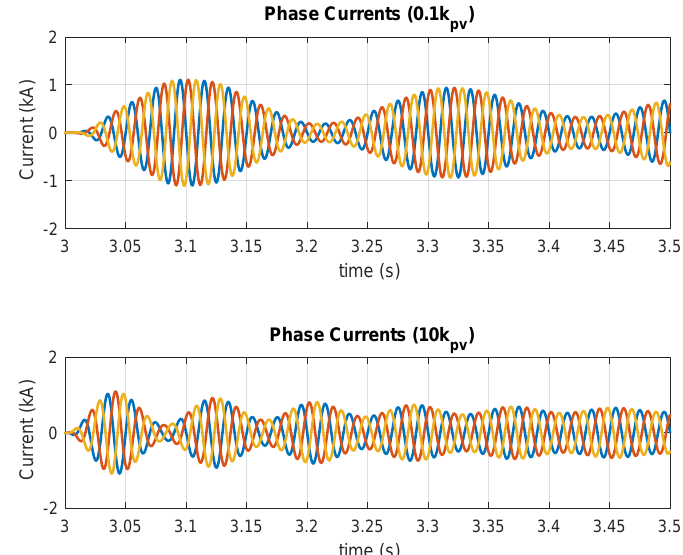
Figure 22. ( Top plot ) time domain plot of Phase AC currents in the abc frame for the case of 0.1 k pv ; ( Bottom plot ) case of 10 k pv